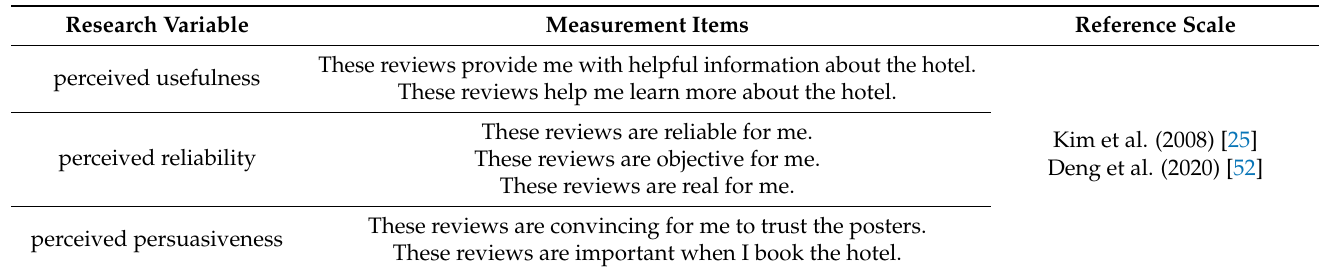
Table 13. Research variable measurement